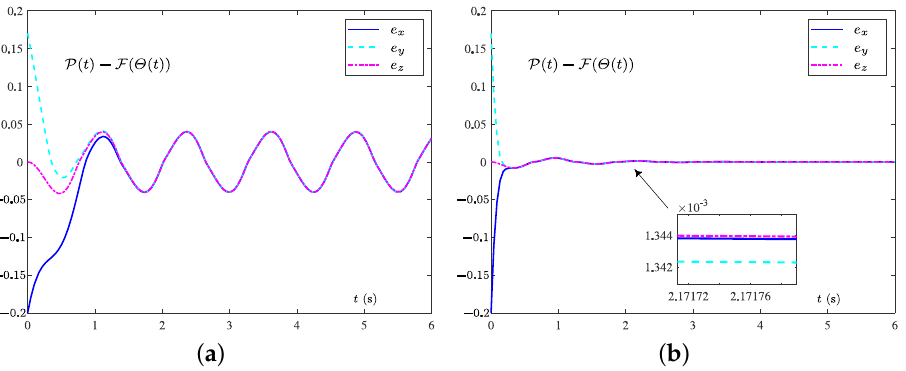
Figure 6. The tracking errors of the mobile manipulator controlled by the LTCZNN model and the DFZNN model under noise δ i ( t ) = 0.3sin ( 5 t ) . In addition, e x , e y , e z are the errors along the X , Y , Z axes. ( a ) By the LTCZNN model. ( b ) By the DFZNN